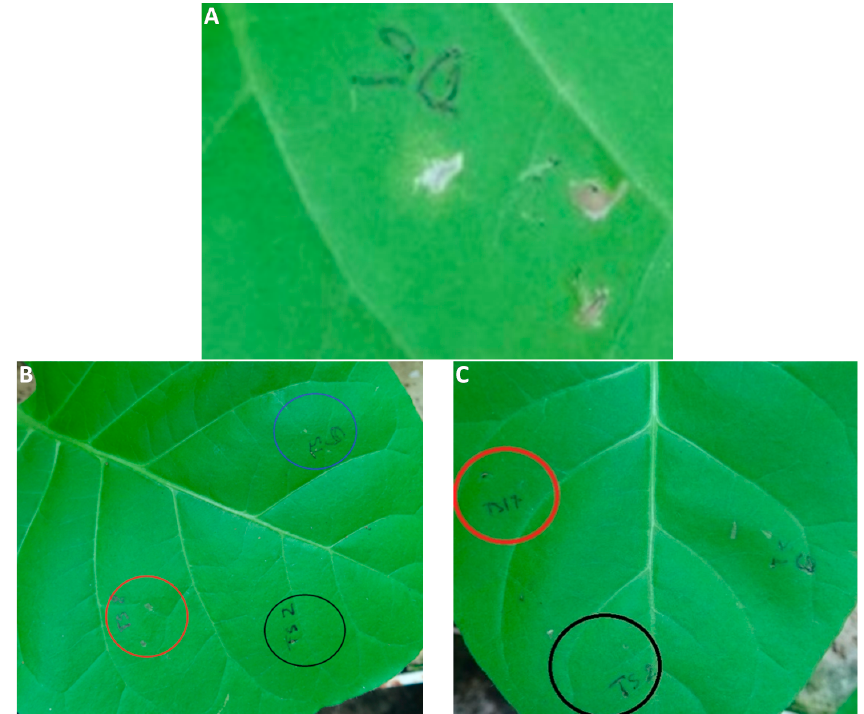
Figure 6. Toxic effect of 5% DMSO ( A ) to leaf of Nicotiana tabacum compared to nontoxic effect of compounds 2 (blue ring), 5 (red ring), and 6 (black ring) ( B ) and nontoxic effect of compounds 6 (black ring) and 14 (red ring) ( C ). The black spots in the injected area of compound 5 in Figure 6B are damages of the leaf tissue caused by a needle.